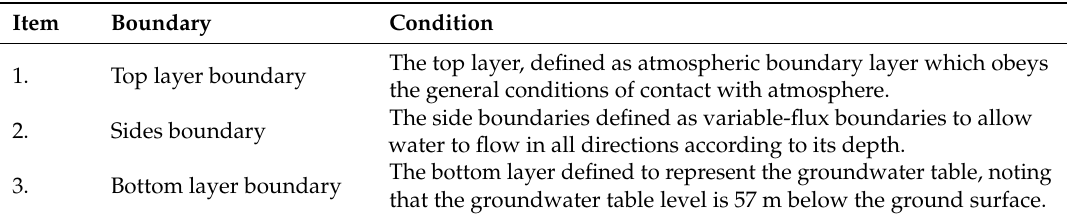
Table 1. The boundary conditions set for the pond in the Hydrus